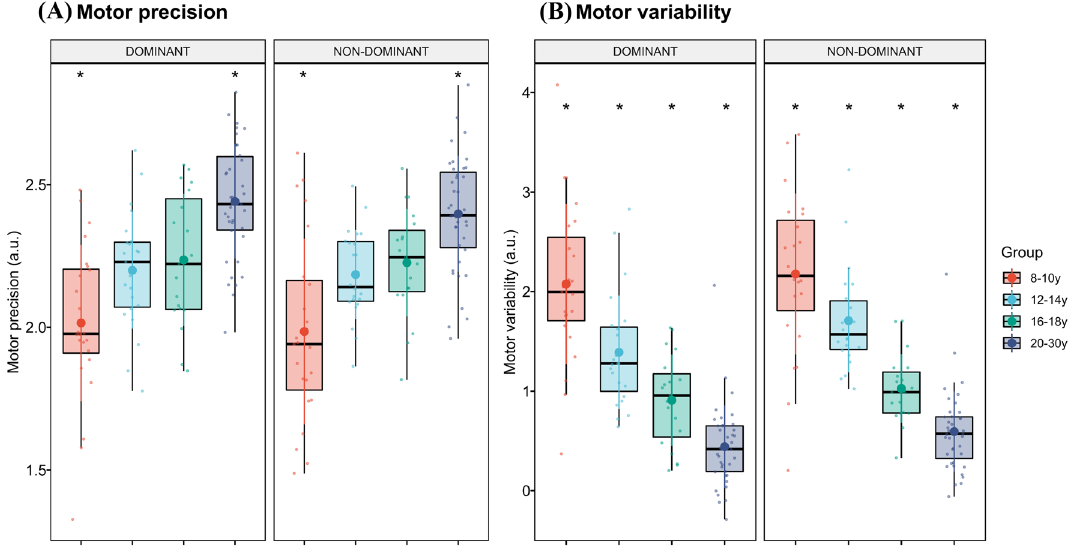
Figure 2. Motor performance. Box plots with individual data points displaying ( A ) precision performance and ( B ) motor variability in the force-tracing task for the different age groups divided by hand used (N = 104 for dominant hand; N = 103 for non-dominant hand). Big filled circle reflects mean value and adjoining lines colored by group reflect standard deviations (SD). *Signifies a significant difference from the remaining groups across hands (p <